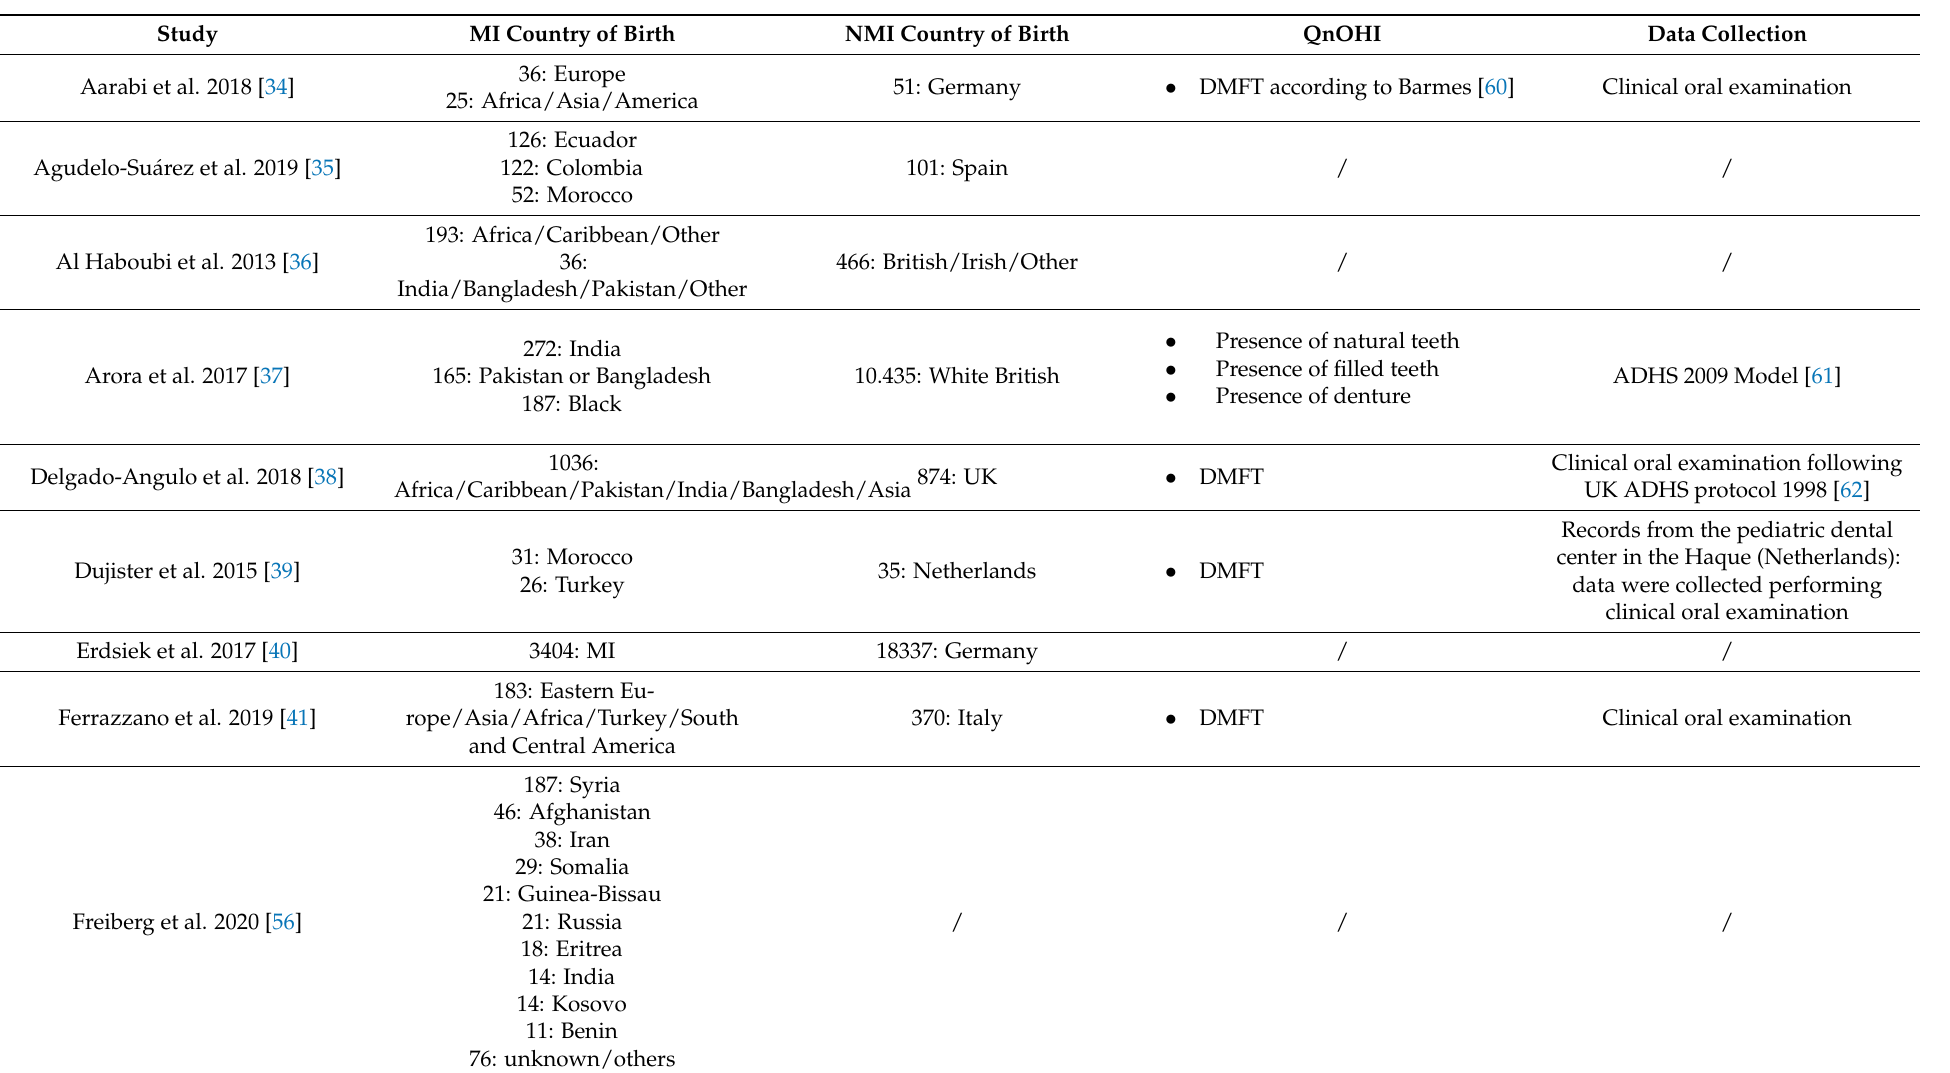
Table 6. MI and NMI country of birth, quantitative oral health indicators (QnOHI) and data collection of the included